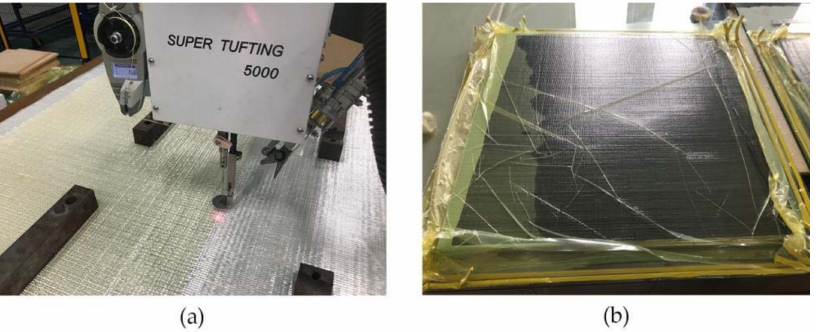
Figure 3. Preparation of GFRP/foam sandwich composites. ( a ) The stitching process. ( b ) Vacuum assisted resin infusion.